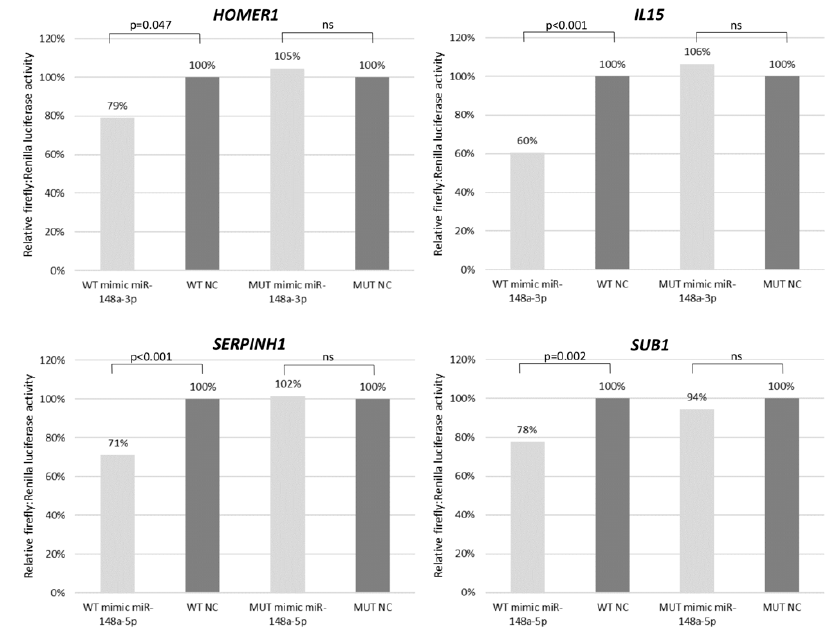
Figure 5. Interaction between mir-148a and its target genes ( HOMER, IL15, SERPINH1 and SUB1 transcripts) shown by dual-luciferase reporter assay in HEK 293T cell line. WT–wild type 3 ′ UTR, MUT–mutant 3 ′ UTR with point mutations in miRNA binding site. Results presented as a mean from two independent experiment, each performed in three replications.